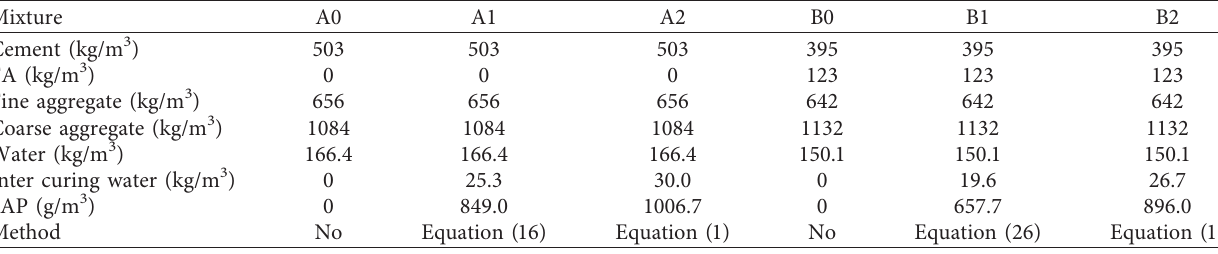
Table 2: Concrete mix proportions.